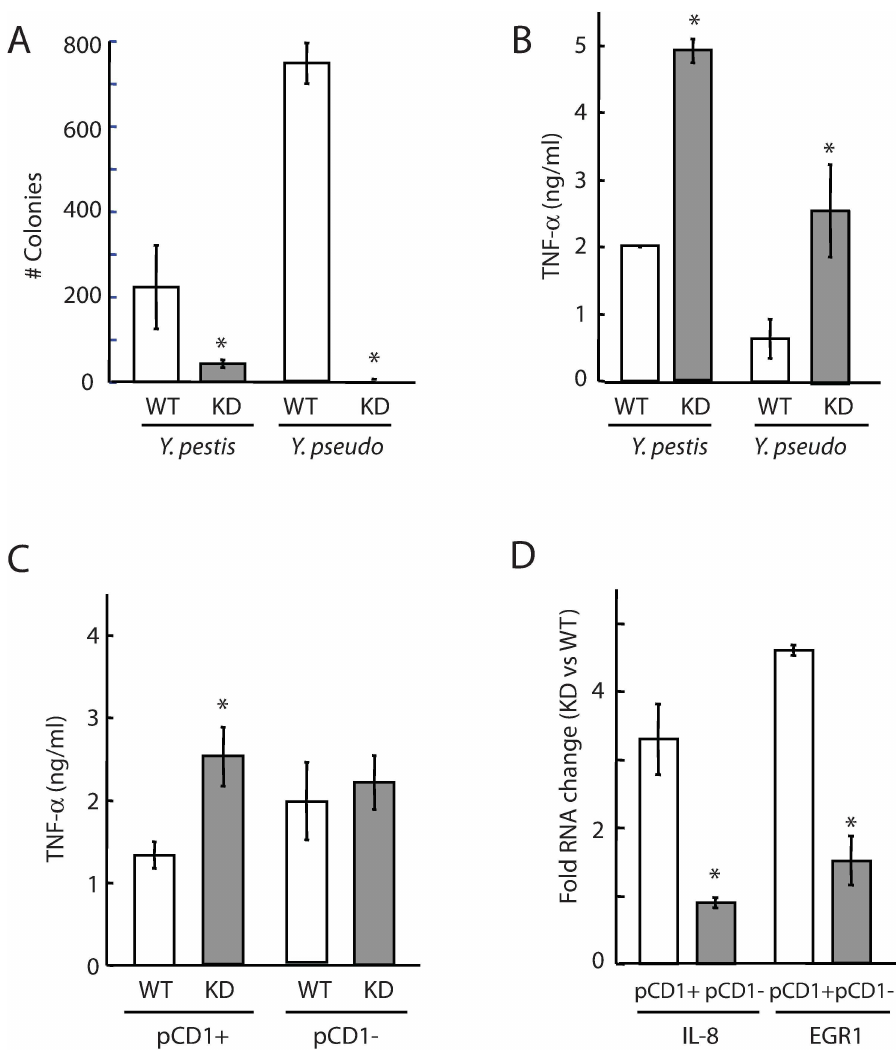
Fig 4. Infection efficiency of Ysr170KD strains. (A) THP-1 cells were infected with Yersinia wild-typeor KD Ysr170 strains at MOI 5 for 30 min to allowfor pathogeninvasion.Serial dilutionsof THP-1 lysates (1:100) were spread on BHI agar plates, and colonieswere counted after 48 hrs. The averagemean and standard deviationfrom three representative experiments are shown. The ‘ * ’ denotes statistical significance(p < 0.05) for numberof coloniesin the Ysr170 KD strains comparedto wild-type(WT). (B) THP-1 cells were infected at MOI 5 with Y . pestis and Y . pseudotuberculosis wild-typeor KD Ysr170 strains. After 24 hrs, cell supernatants were collectedand analyzedby ELISA. The averagemean and standarddeviationfrom three representative experiments are shown. The ‘ * ’ denotes statistical significance(p < 0.05)for TNF- α release in the Ysr170 KD strains comparedto wild-type(WT). (C) THP-1 cells were infected at MOI 5 with Y . pestis pCD1+ and pCD1- strains that expressedwild-typeor KD Ysr170. After 24 hrs, cell supernatantswere collectedand analyzedby ELISA. The averagemean and standard deviationfrom three representative experiments are shown. The ‘ * ’ denotesstatistical significance (p < 0.05)for TNF- α release in the Ysr170 KD Y . pestis pCD1+ strains comparedto wild-type(WT). (D) THP-1 cells were infected at MOI 4 with Y . pestis pCD1+ and pCD1- strains that expressedwild-typeor KD Ysr170. After 24 hrs, total RNA was extracted and RT-PCR analysiswas performed using specific probesto IL-8 and EGR1. The relative RNA levels are presentedas fold expression in the KD Ysr170 strains comparedto wild-type.For each sample, the RNA levels were normalizedto 5S rRNA. The ‘ * ’ denotesstatistical significance(p < 0.05)for fold RNA change in IL-8 and EGR1 expression betweenpCD1+ and pCD1- strains. The averagemean and standarddeviationfrom three representative experiments are